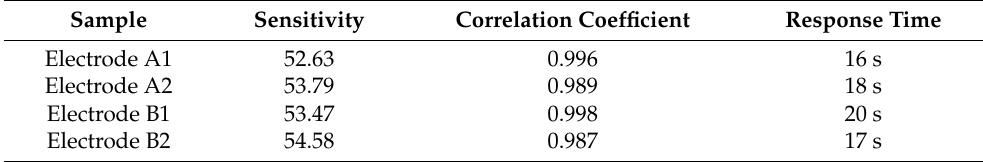
Figure 10. OCP of the electrode obtained from two lots in different pH levels to demonstrate the repeatability. Table 3. The pH sensing characteristics of the electrodes obtained from different lots.